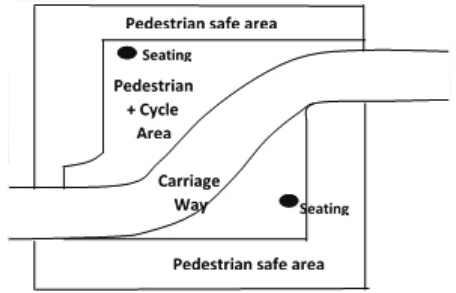
Figure 7. Layout of Byng